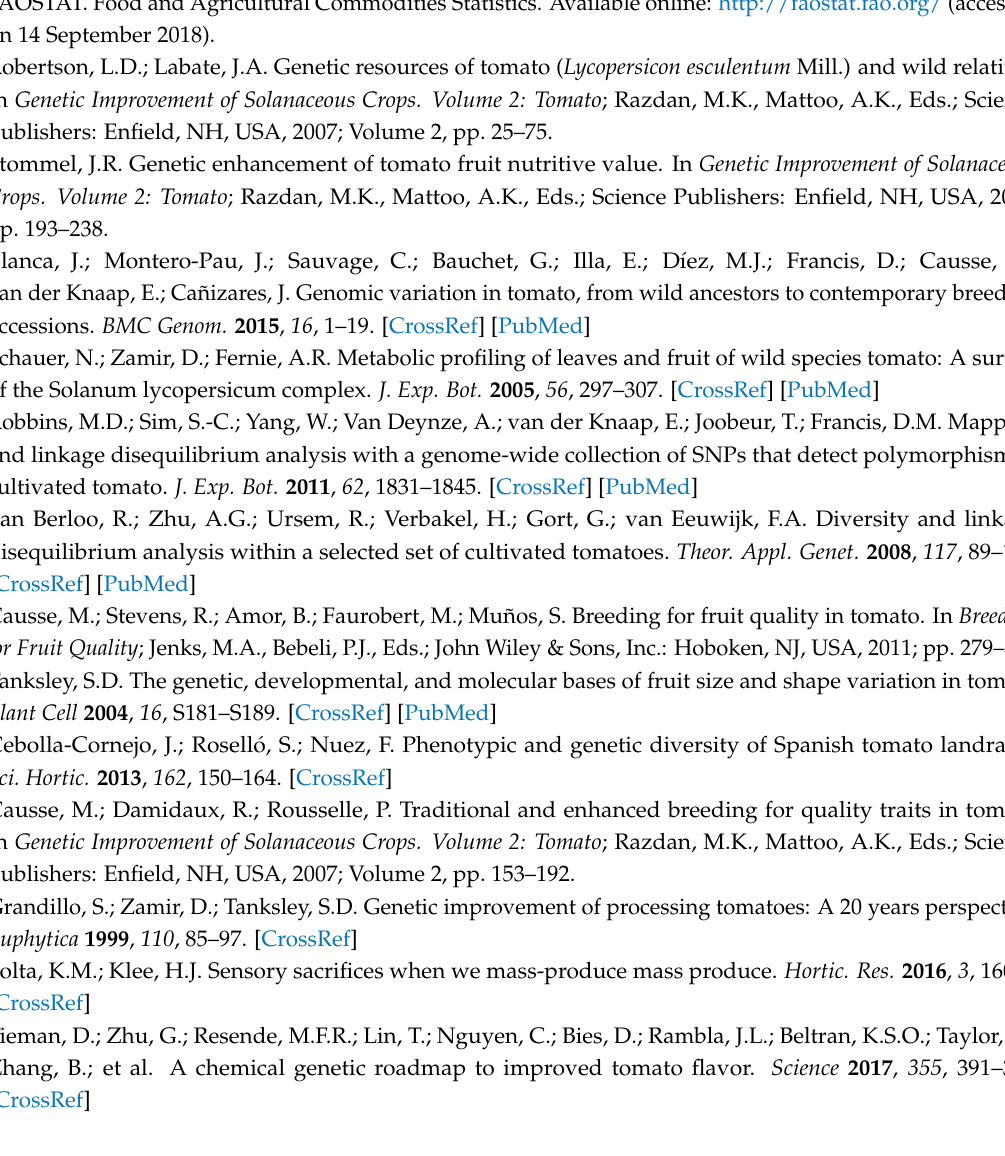
Table S1: Mean values per accessions for the chemical and morphological traits studied. At the bottom, least significant difference ( p < 0.05) between means; Table S2: Pearson genotypic correlations between chemical, morphological, and sensory traits within the fresh market (upper part) and cherry (lower part) groups, using mean values per genotype of all available data. Significance levels: *** p < 0.001, ** p < 0.01, * p <